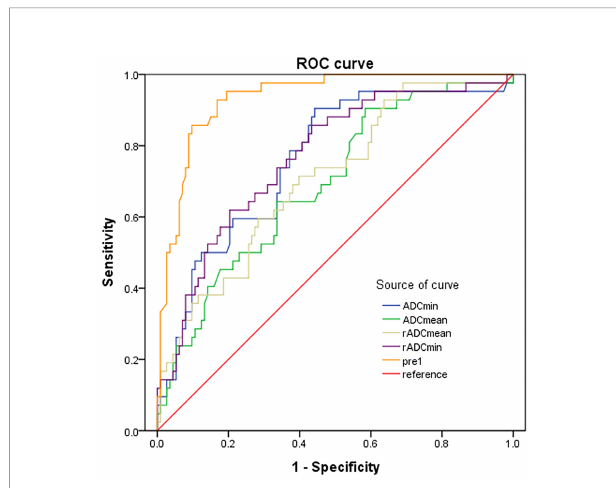
FIGURE 6 | ROC curves of ADC indicators and combined predictors for differentiating LGGs from HGGs.